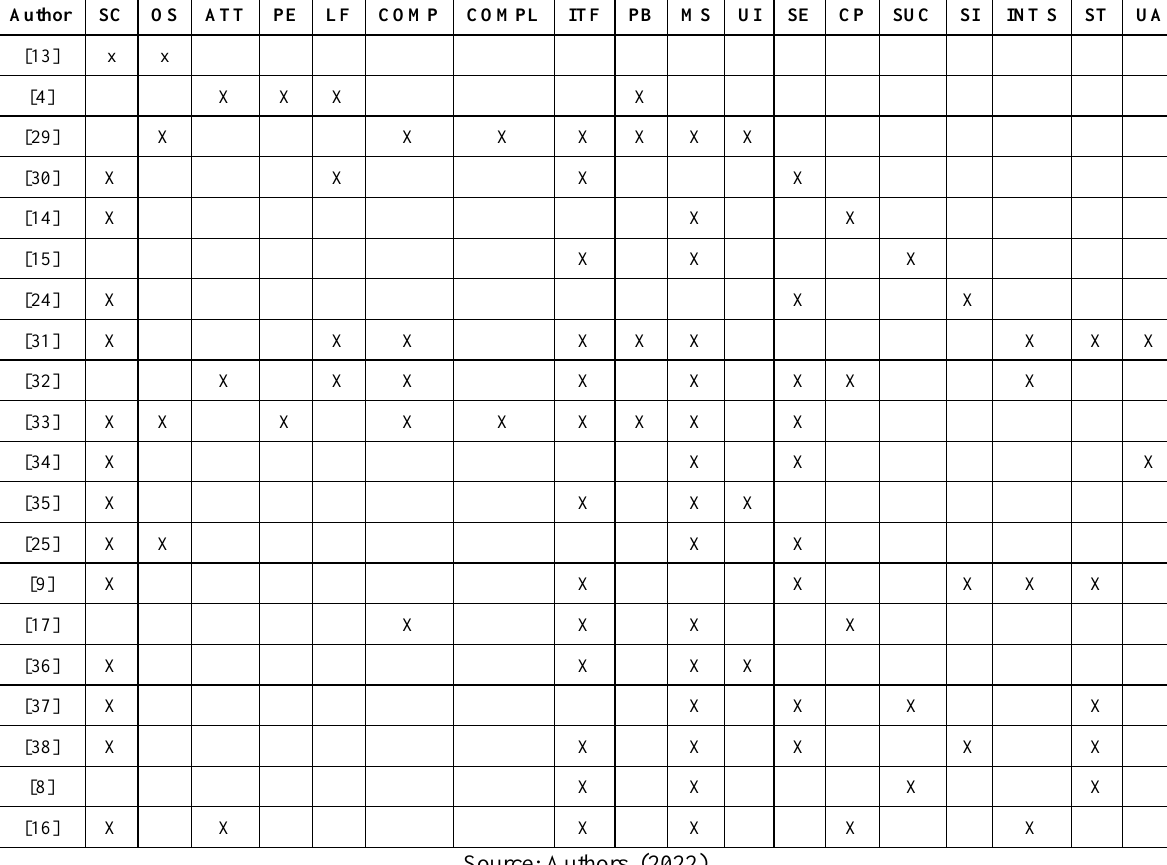
table 2 compiles the determinants of e-procurement adoption based on their similarities. Table 2: Summary of determinants of e-procurement